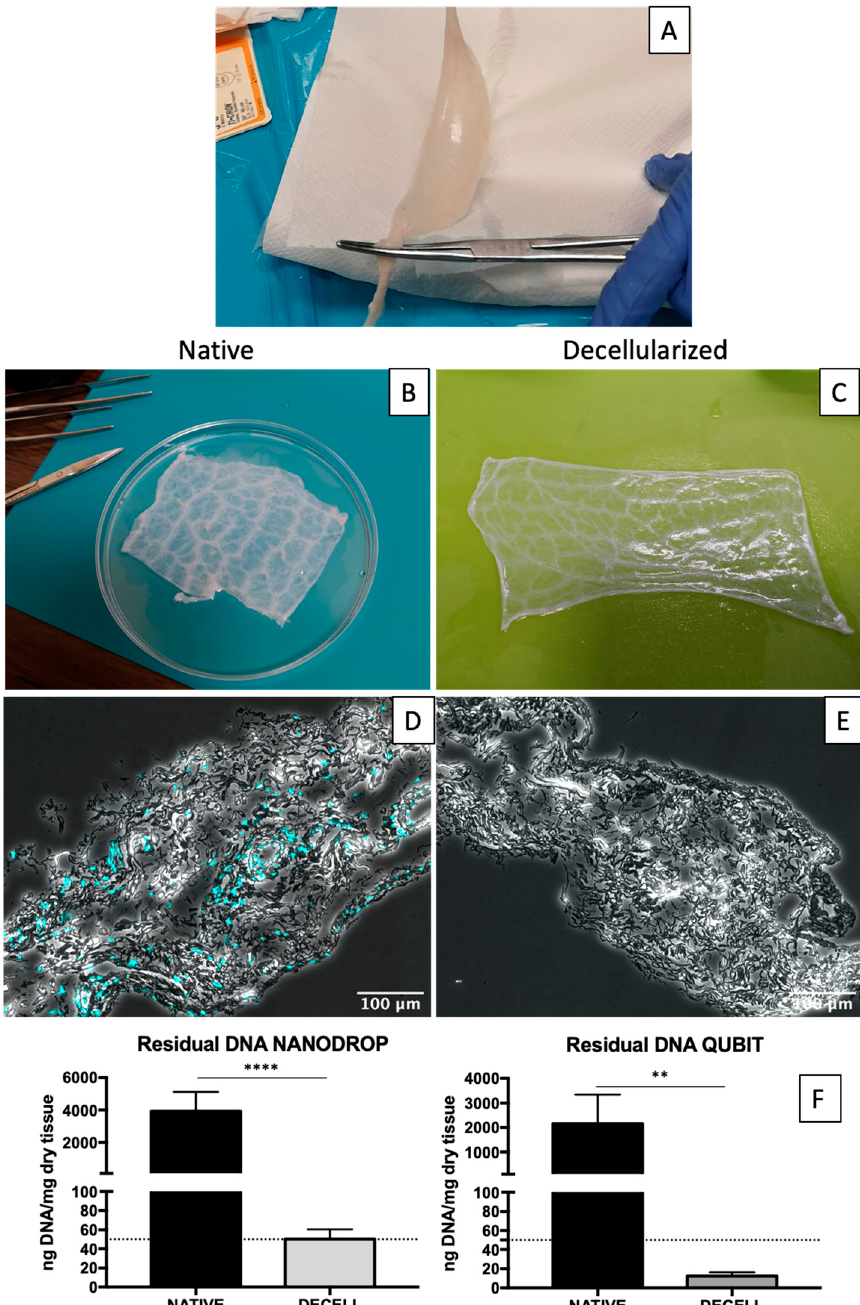
Figure 1. SIS conduit after gentle mechanical removal of the two-external layers of the jejunum ( A ). Native ( B ) and decellularized ( C ) SIS: collagenous fibre bundles are visible through the transparent surface. ( D ) DNA quantification performed in native and decellularized SIS samples: with NanoDrop on the left and with Qubit on the right. Data on graphs show mean ± SD. Data analysed by t -test. **** p < 0.0001 and ** p < 0.01. Merge between phase contrast and DAPI images in case of native ( E ) and decellularized ( F ) shows absence of nuclei in the latter.